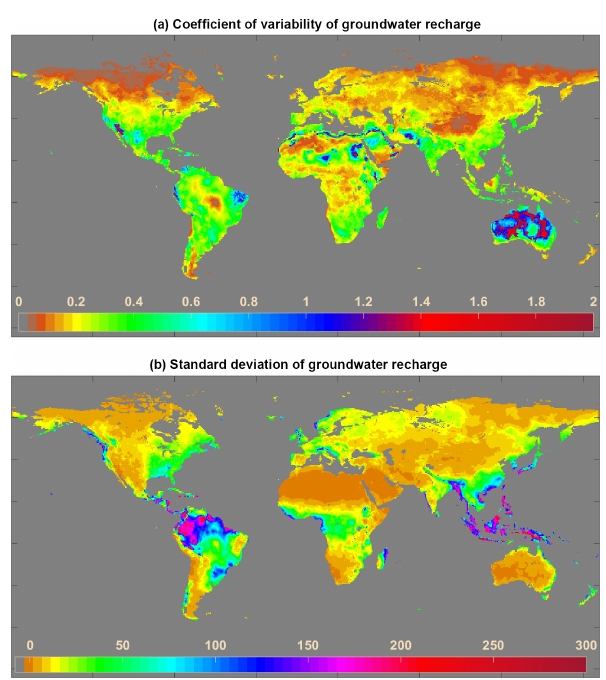
Figure 10. Map showing (a) coefficient of variability and (b) stan- dard deviation of annual groundwater recharge from 1981 to 2014.